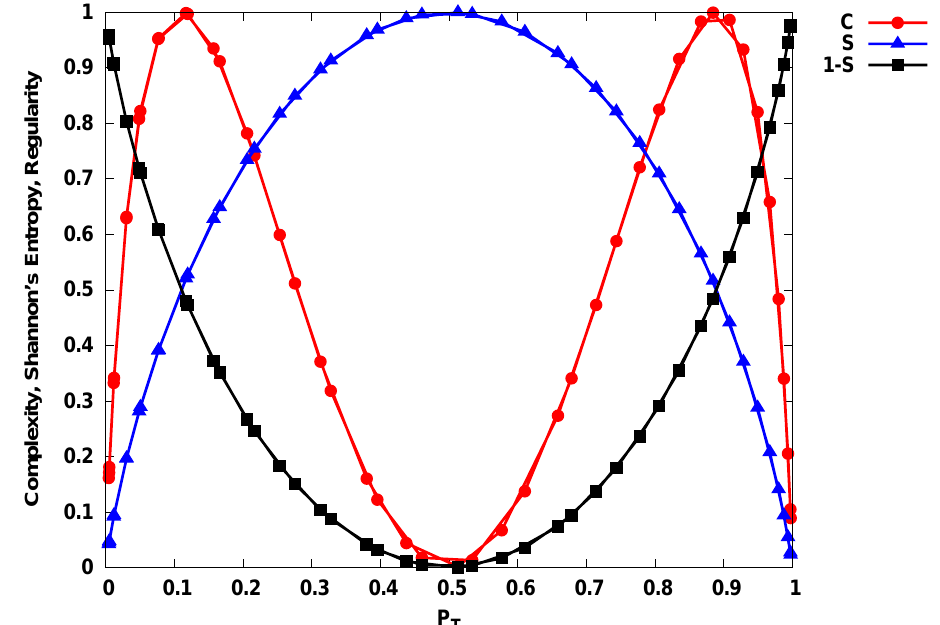
Figure 6. Experimental results for Shannon’s information S (blue triangles), complexity C = 4 S ( 1 − S ) (red dots), and regularity 1 − S (black squares), as a function of the probability of